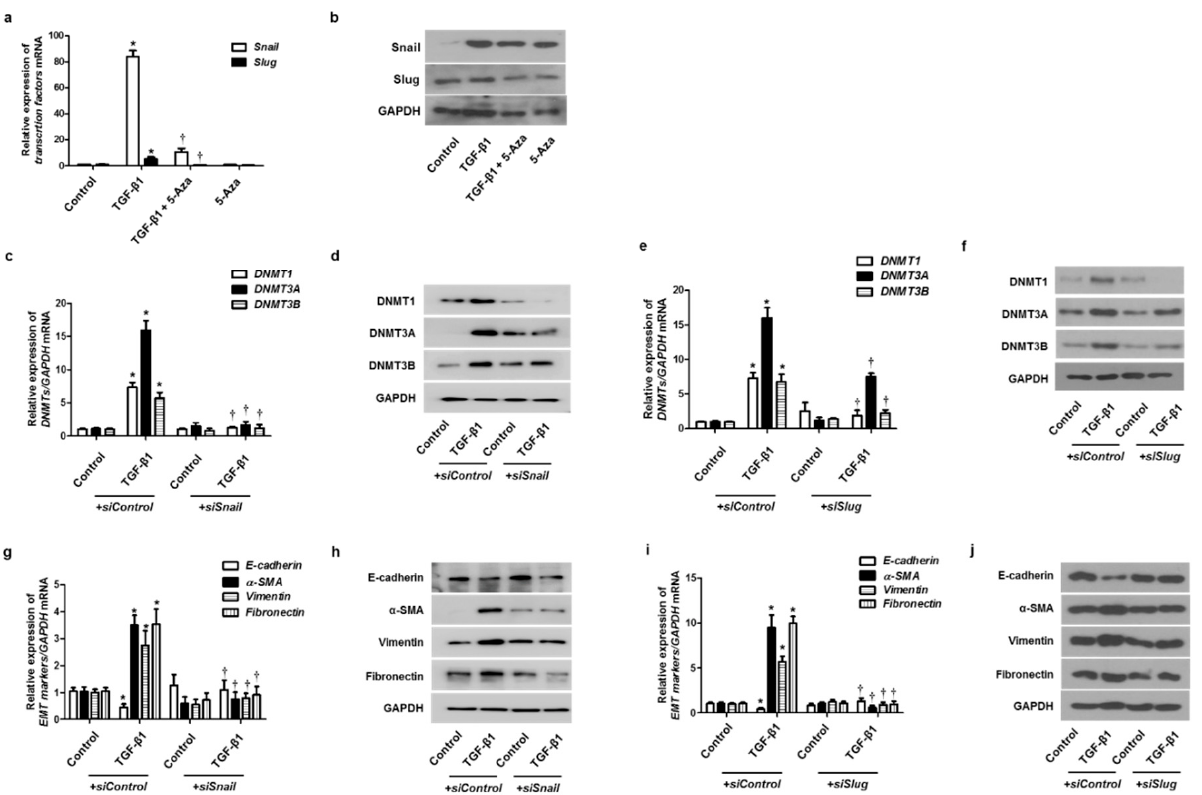
Figure 6. EMT-related transcription factor with TGF- β 1 treatment on DNMT expression. A549 cells were pretreated with 5-Aza before TGF- β 1 treatment: ( a ) mRNA and ( b ) protein levels of Snail and Slug were determined using real-time PCR and Western blotting, respectively, normalized to GAPDH. Specific Snail and Slug siRNAs (100 nM) were transiently transfected before treatment with or without TGF- β 1 (5 ng/mL) for 24 and 72 h; ( c – j ) expression of DNMT and EMT-related markers was determined using real-time PCR and Western blotting. Data are presented as mean ± SEM. Results were obtained from at least three independent experiments using a single A549 cell line. * p